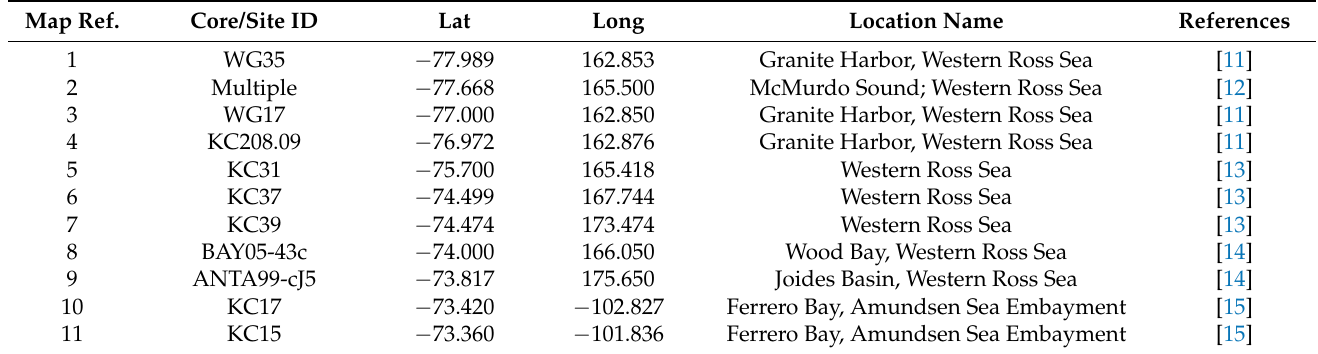
Table 1. Marine core sites with diatom-based sea ice proxy records for all or part of the past 2 ka. Map